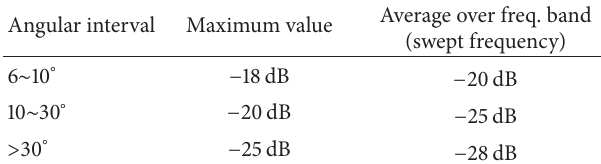
parabolic wires are in front of the primary parabolic main reflector metal mesh and in position with angle of 45 ∘ to the polarization of the horn feed antenna. For